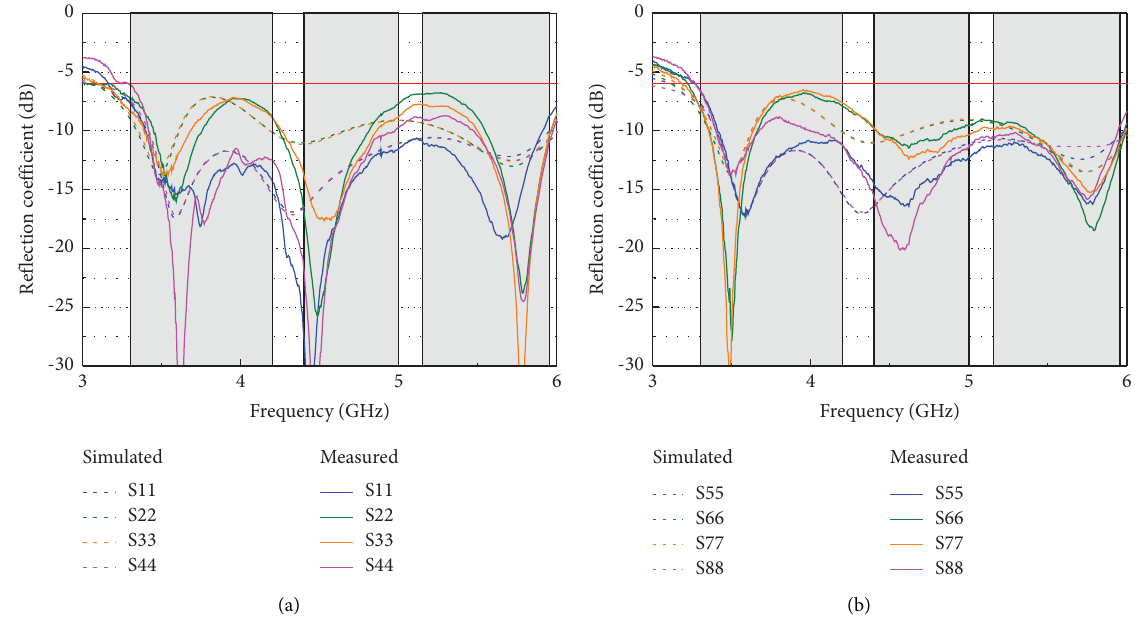
Figure 7: Simulated and measured refection coefcients of the (a) antenna 1 to antenna 4 and (b) antenna 5 to antenna 8.